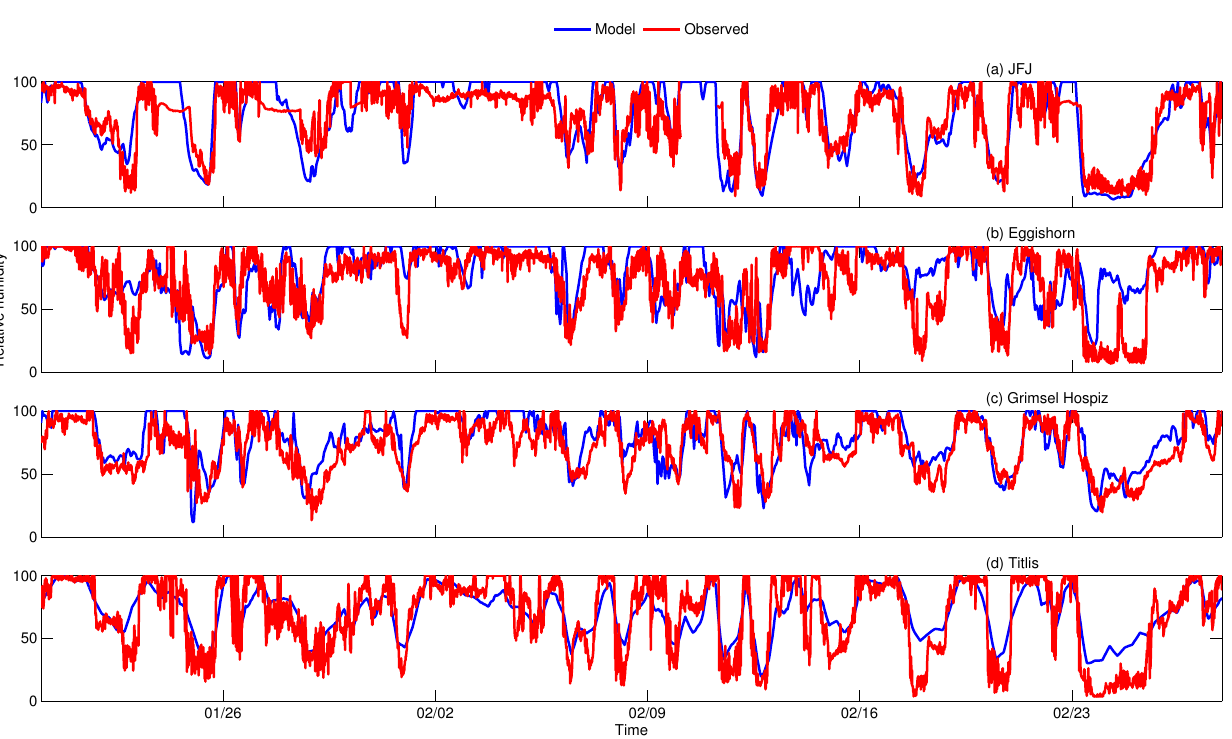
Figure 3. A comparison of the relative humidity at four MeteoSwiss observation stations with the WRF control simulation during the INUPIAQ field